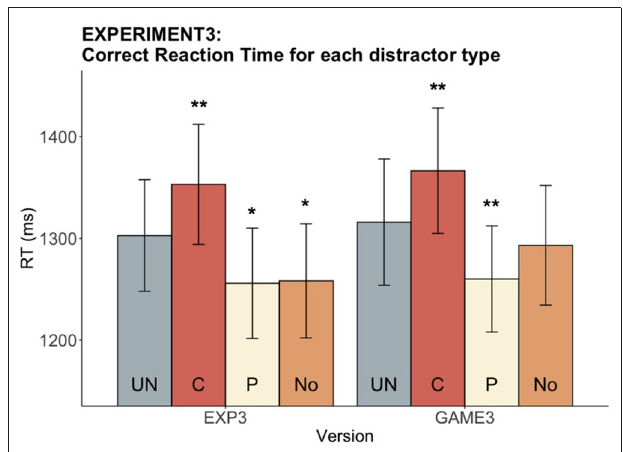
FIGURE 7 | Experiment 3: Reaction time for each distractor type in both versions. The bar chart indicates the mean RTs while the error bars shows the 95% confidence intervals. The distractor conditions are color-coded, with the UN (gray) being the baseline condition for pairwise statistical comparisons with the other three conditions. Asterisks indicate that mean RT for the corresponding condition differs significantly from the UN mean RT (* p < 0.05, ** p <